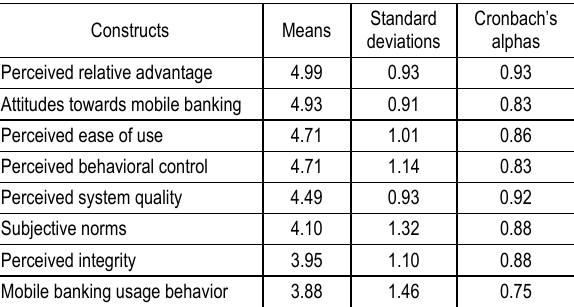
Table 2. Descriptive statistics and reliability measures